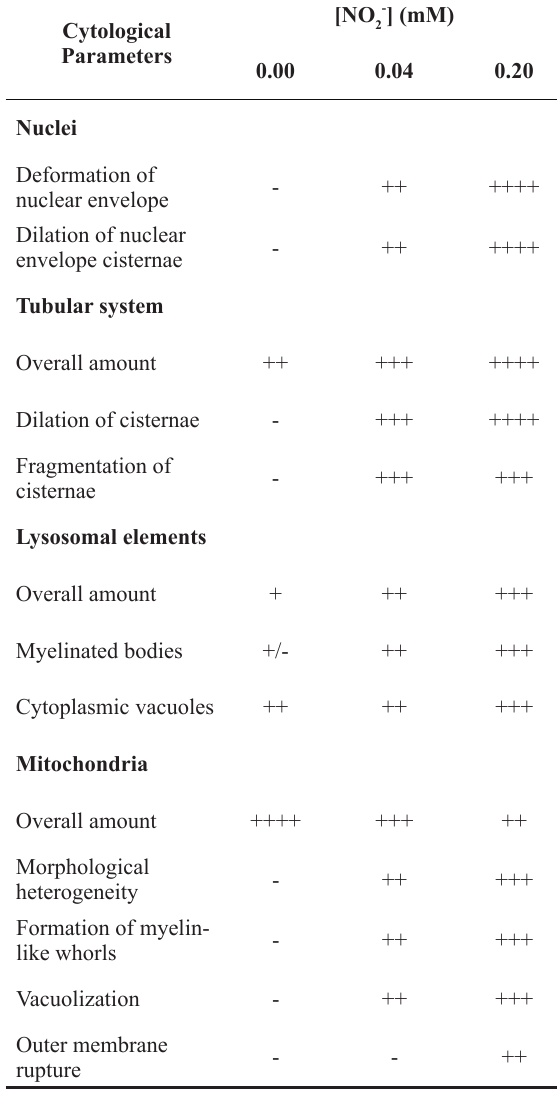
Ultrastructural changes in the gill MRCs of C. macropomum after exposure to NO 2- concentrations for 96